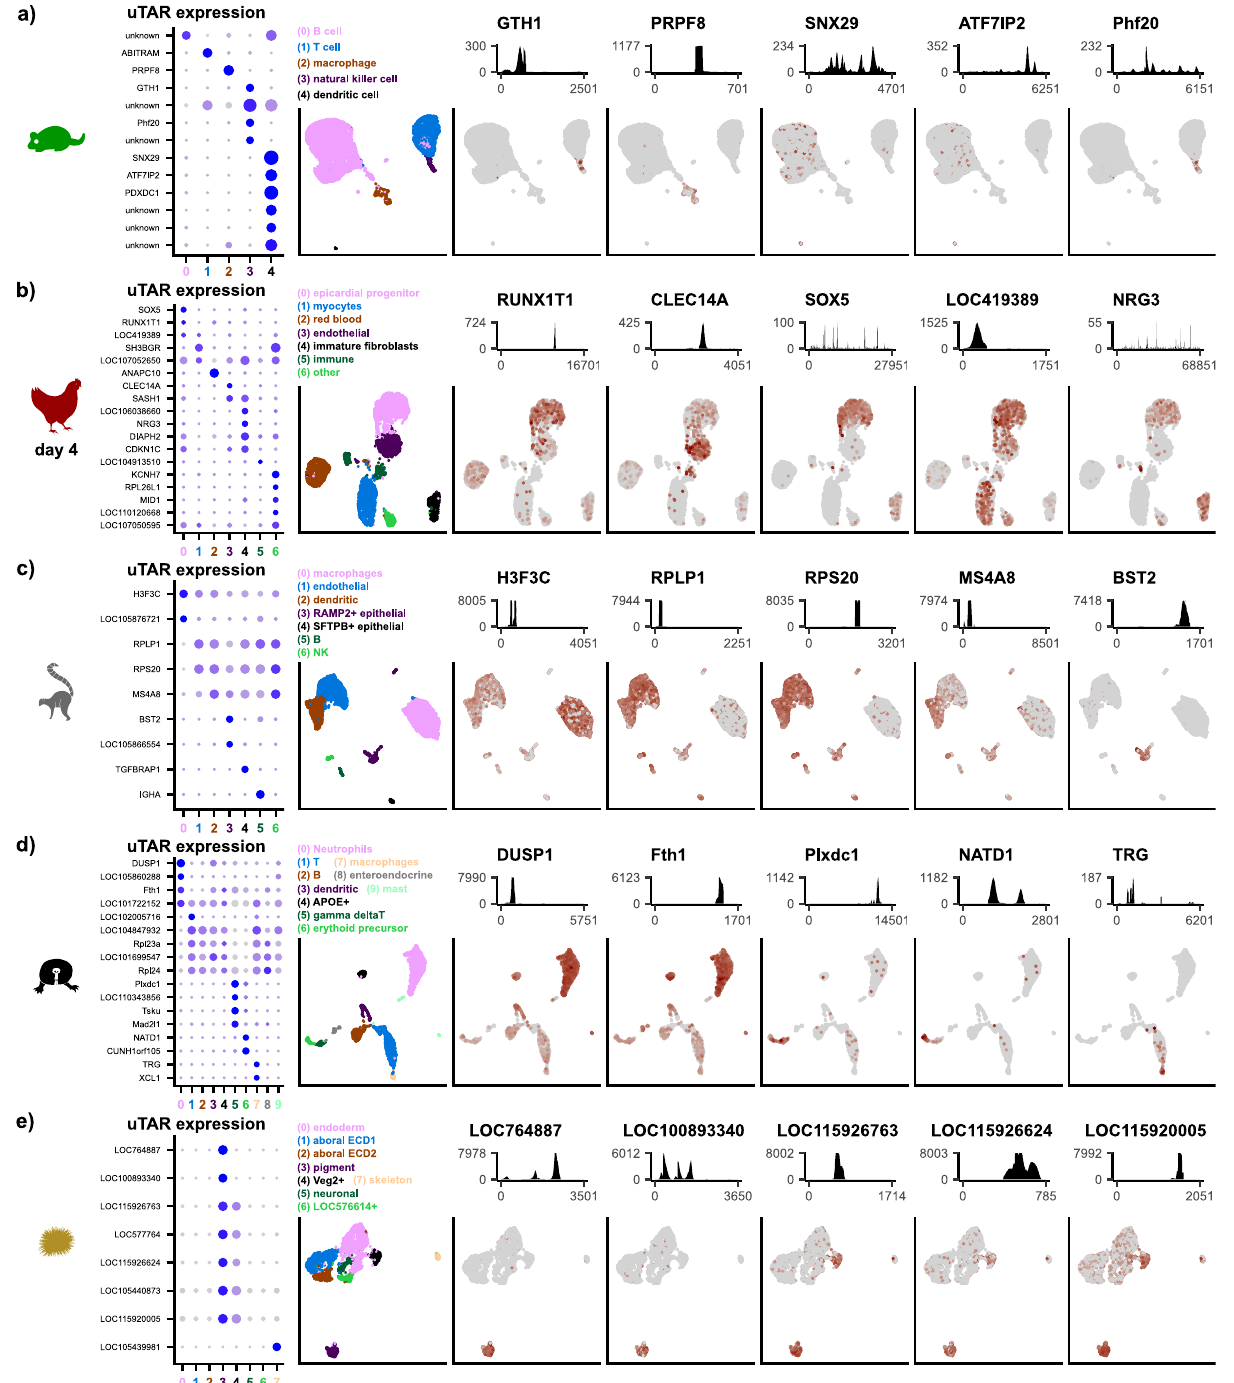
Fig. 3 Biologically relevant information is contained in uTAR features. Differential uTAR feature analysis for mouse spleen data ( a ), chicken heart day 4 data ( b ), gray mouse lemur EPCAM + lung data ( c ), naked mole rat spleen data ( d ), and sea urchin embryo data ( e ). Dot plot (left) of differentially expressed uTAR features that are labeled based on sequence homology and cell clusters are numbered along the x -axis. Dot size corresponds to the percentage of cells that express the uTAR feature while darker blue color corresponds to higher level of log-e-normalized expression. UMAP (second left) colored and dimensionally reduced using gene expression features where cell clusters are labeled above the UMAP. Total coverage plot (top) of 5 uTARs along the length of the uTAR feature on the x -axis. The corresponding feature plot on UMAP projection is shown below the coverage plots where darker brown color correlates with higher log-e-normalized expression in each